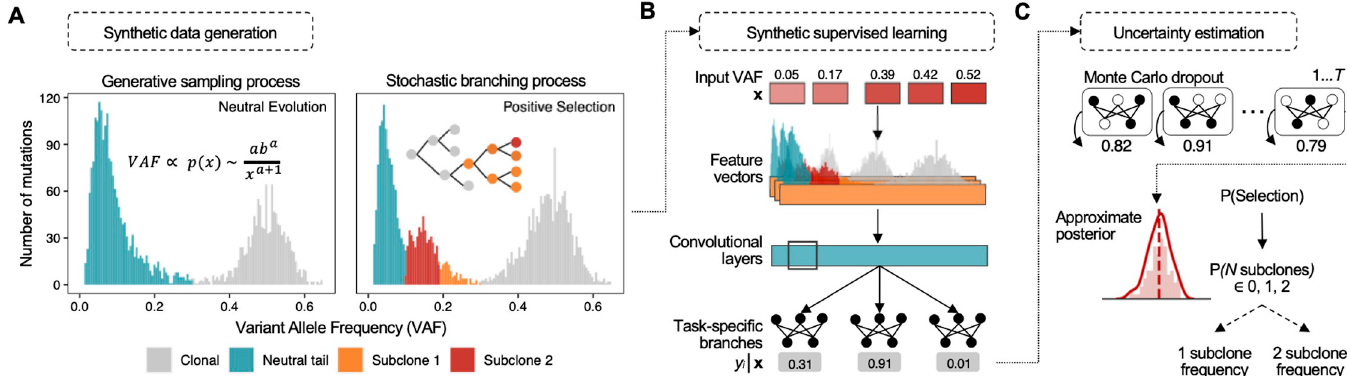
Fig 1. (A) TumE integrates a generative sampling process and stochastic simulation of cancer evolution to build well-specified synthetic variant allele frequency (VAF) distributions with respect to data observed in bulk sequenced tumour biopsies. Assuming copy-neutral diploid regions of tumour genomes, the generative sampling process uses the observation that neutral VAF distributions can be described by a power-law or Pareto neutral ‘tail’ [16,30] in addition to a dispersed clonal peak. By sampling empirically valid Pareto distributions, rapid realizations of the null hypothesis of neutral evolution encoded in the VAF distribution can be created (Methods). The stochastic branching process model of tumour evolution is then used to link parameters and latent states, relevant to positive subclonal selection, back to VAF distributions (Methods). (B) Synthetic supervised learning utilizes neural networks capable of handling the complete dimensionality of the simulated VAF distributions, x , to solve the inverse problem of identifying the evolutionary parameters and latent states, y , assigned to each synthetic VAF distribution. (C) We can then quantify model uncertainty using a computationally efficient form of Bayesian deep learning called Monte Carlo dropout [26,26]. Approximate posteriors are generated by performing T stochastic passes through the trained neural